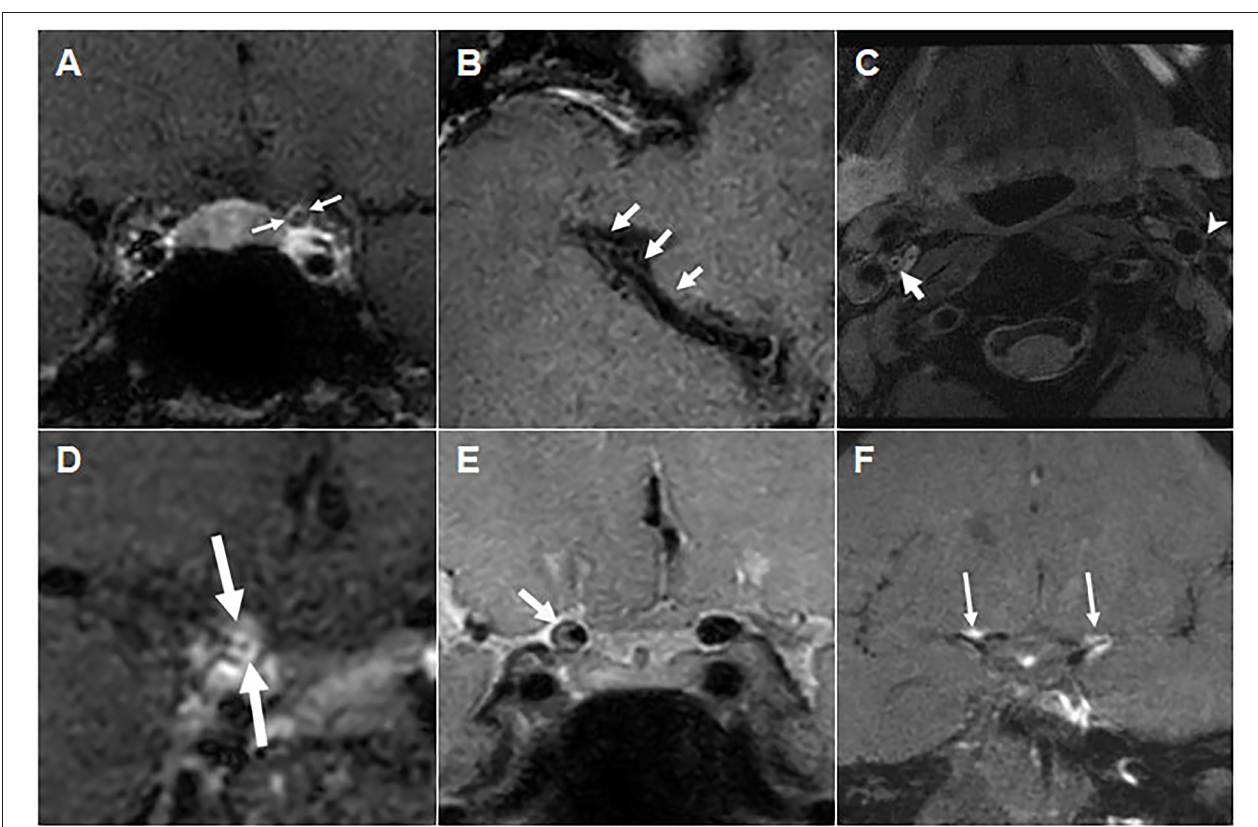
FIGURE 2 | Vascular wall and intraluminal changes on high-resolution vascular wall MRI. (A) Post-contrast T1 weighted image of Patient 1, showing negative remodeling and diffuse concentric wall thickening (arrows) in the left distal ICA, along with mild contrast enhancement. (B) Contrast-enhanced T1 weighted image of Patient 2, showing a diffuse luminal narrowing of the right MCA M1 distal segment without contrast enhancement. (C) Proton density-weighted image of Patient 3, showing concentric intraluminal thickening of the right proximal ICA without definite occlusion and with no overt wall enhancement (post-contrast T1 weighted image not shown). (D) Contrast-enhanced T1 weighted image of Patient 4, showing concentric wall thickening and strong circumferential enhancement of the right ICA supraclinoid segment. (E) Proton density-weighted image of Patient 5, showing eccentric wall thickening with inner eccentric contrast enhancement (post-contrast T1 weighted image not shown) of the right distal ICA. (F) Contrast-enhanced T1 weighted image of Patient 9, showing multifocal vessel wall and subarachnoid nodular enhancement of bilateral ICA bifurcation and left ACA A1 segment (arrows). ACA, anterior cerebral arteries; aPLs, antiphospholipid antibodies; ICA, internal